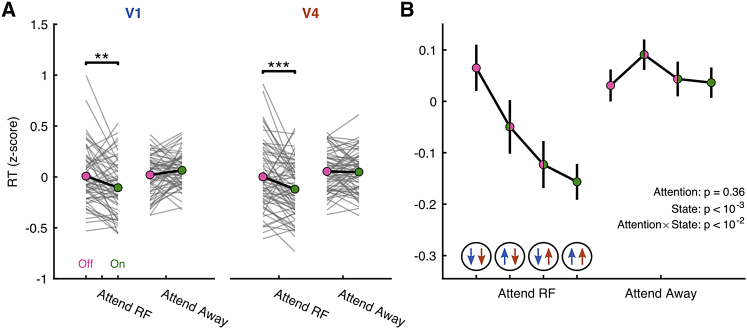
Across-area coordination of On-Off dynamics predicts behavioral performance(A) On versus Off phase of population activity at the time of target dimming, determined individually for V1 and V4, predicts behavioral performance. RT decreases when attention is directed toward the RFs and either V1 or V4 is in an On phase.(B) RT decreased from when both areas were Off, through V1 On–V4 Off, through V1 Off–V4 On, to V1 and V4 On when attention was directed toward the RFs.Statistics: two-sided Wilcoxon signed rank test (A), and multilevel linear mixed-effects model (B).Data are represented as means ± SEMs across recordings; FDR corrected significance levels ∗p < 0.05,∗∗ p < 0.01, and ∗∗∗p < 0.001.